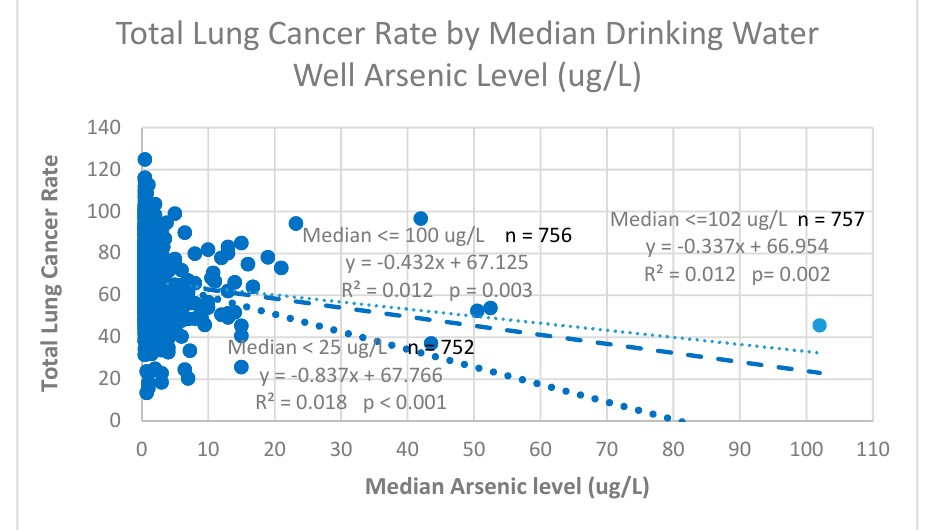
Figure 2. Linear regression of lung cancer rate by median drinking water well arsenic level over three exposure intervals.